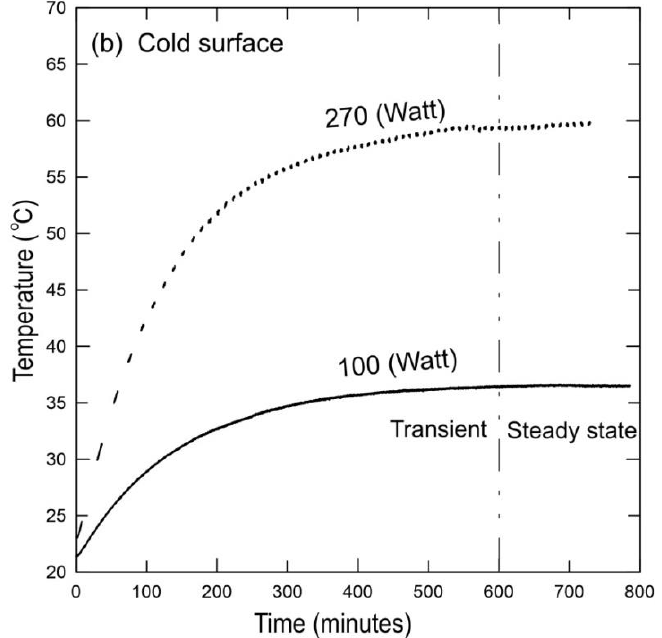
Figure 3. Steady-state condition reached after almost 600 min: ( a ) hot stainless-steel surface; ( b ) cold stainless-steel surface.